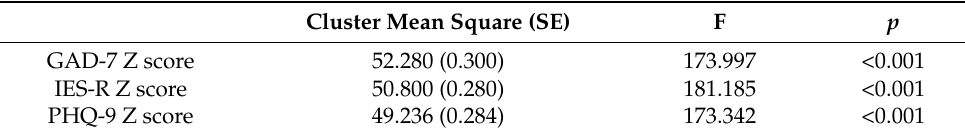
Table 2. K-Means Cluster Analysis features. Dispersion analysis. Table 2. K ‐ Means Cluster Analysis features. Dispersion analysis.